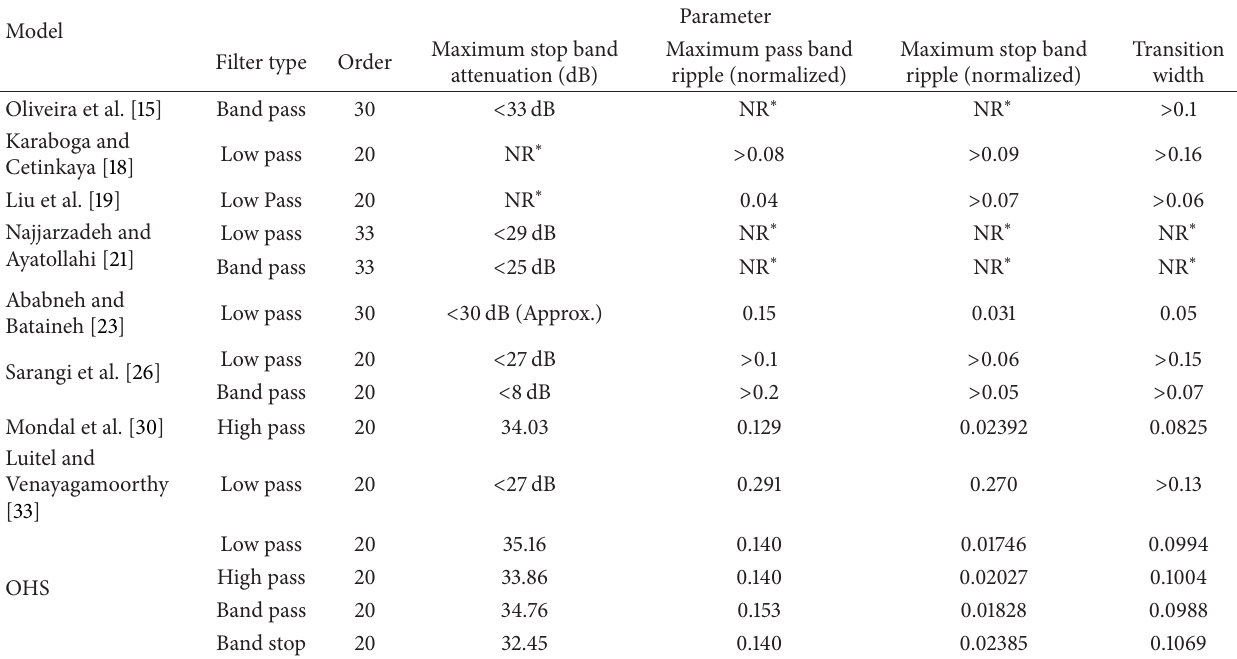
Table 15: Comparison of OHS-based results with other reported